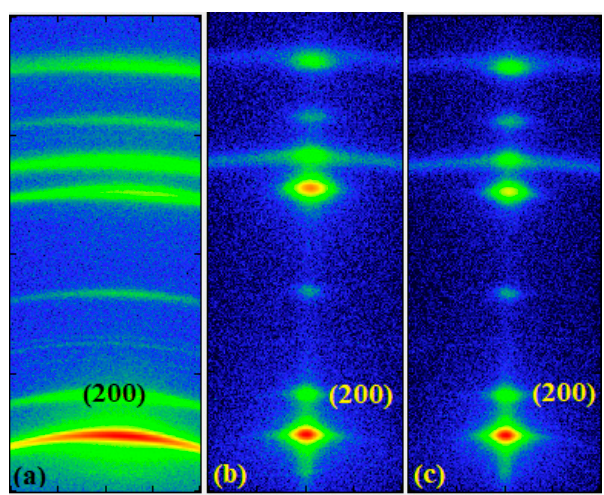
Figure 6. 2D WAXS patterns of oriented UHMWPE/gold nanocomposites at ( a ) low (DR5) draw ratio, ( b ) medium (DR70) draw ratio, and ( c ) high (DR150) draw ratio. The horizontal axis corresponds to the drawing direction.